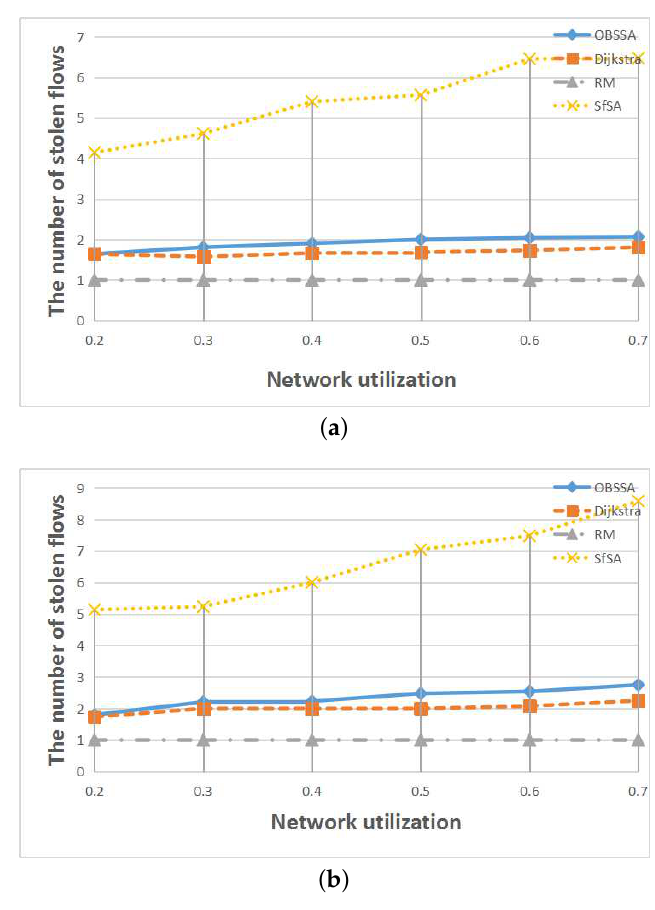
Figure 14. The relationships between the number of stolen flows and the network utilization. ( a ) N = 50, F = 15; ( b ) N = 70, F =